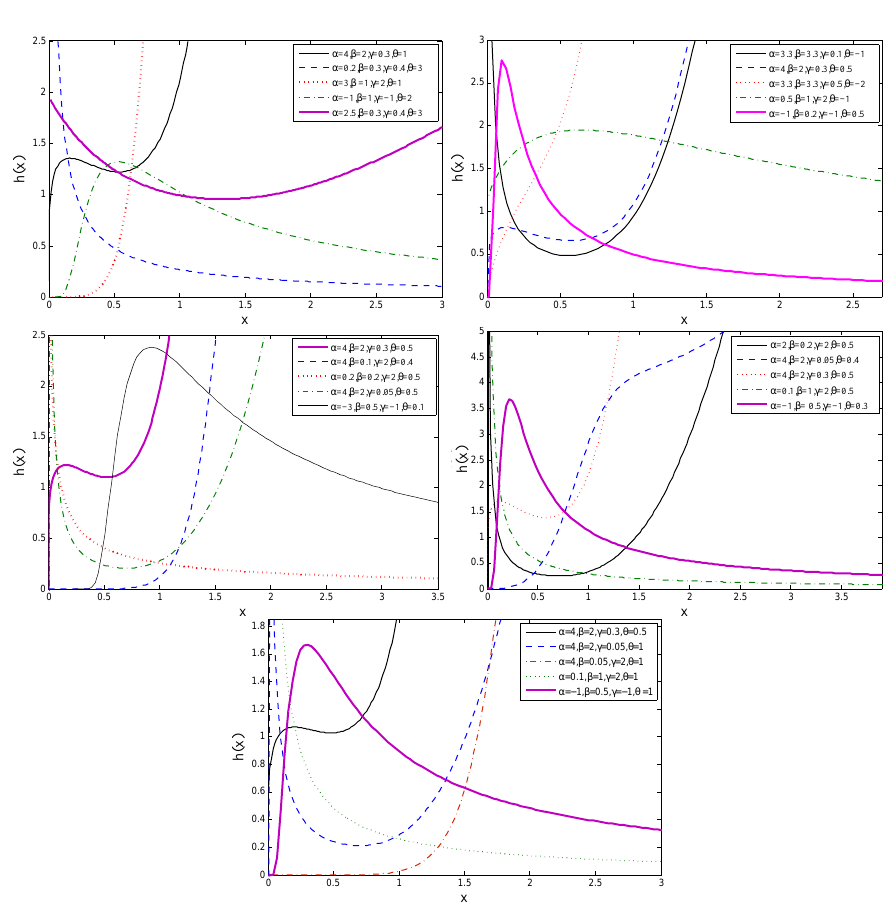
Figure 2 – Plots of the OWPS failure rate function for some parameter values: odd Weibull Poisson (top left), odd Weibull geometric (top right), odd Weibull logarithmic (middle left), odd Weibull negative binomial (middle right) and odd Weibull binomial (bottom)